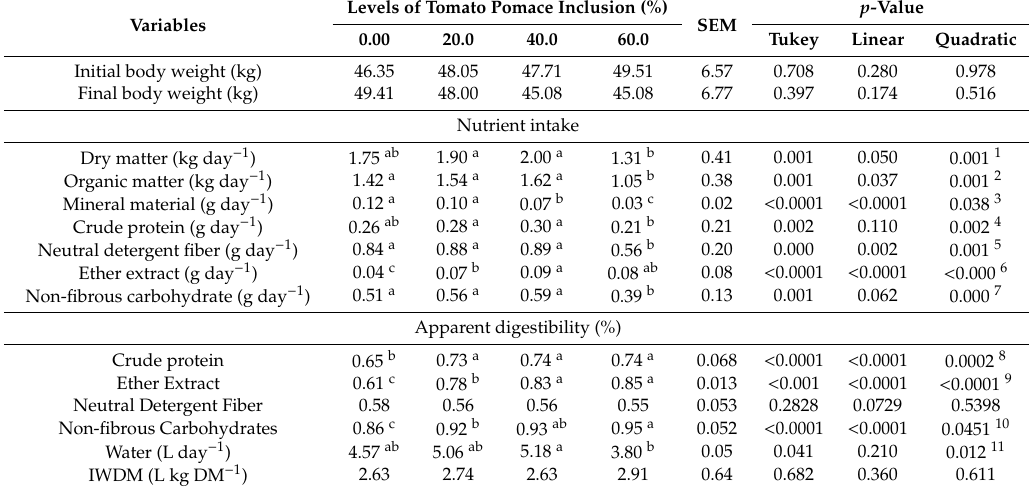
Table 2. Body weight and nutrient intake by dairy goats fed with di ff erent levels of inclusion of tomato